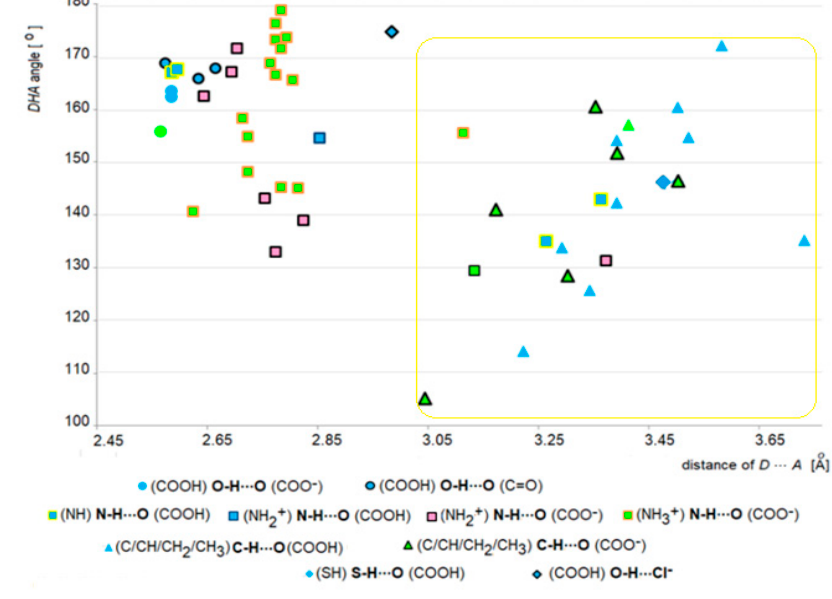
Figure 6. Diagram of the H-bond distance (Donor ... Acceptor) and bond angle (Donor-Hydrogen ... Acceptor) in proline and ACEI structures (19 structures; reference codes are included in the Table 1). In the perindopril-derived crystals, (OH_COOH) O-H ... O (COO-) , (NH2 + ) N-H ... O (COO-) and (NH3 + ) N-H … O (COO-) and (C-) C-H … O (COOH) interactions are observed (colors of fulfilment are consistent with the three types of proline-based tectons observed in the crystals of proline and ACEI: blue-I, green-II, pink-III; weak interactions are marked by the yellow frame).